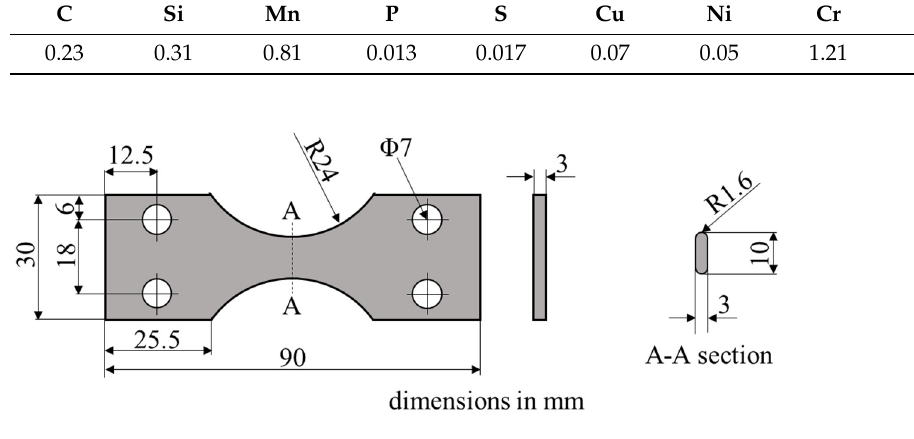
Figure 1. Shape and dimensions of the specimen (mm).